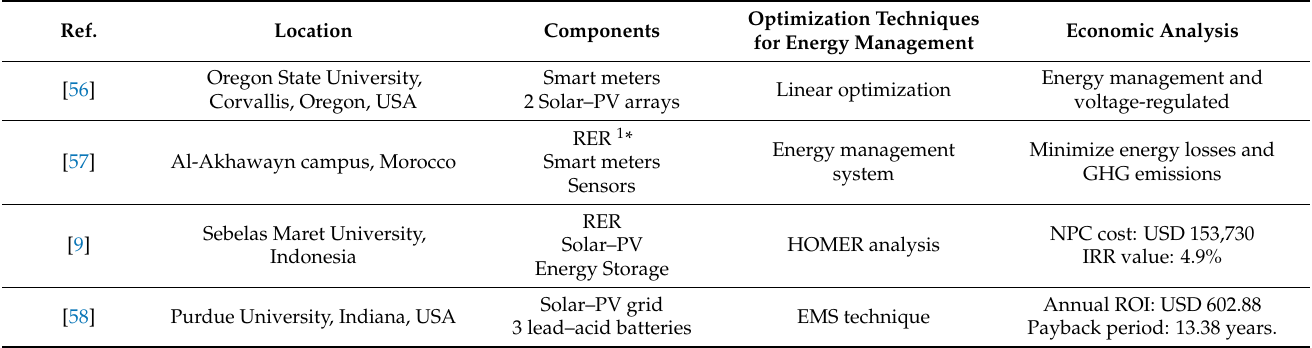
Table 2. A survey of optimization techniques used in campus microgrids.